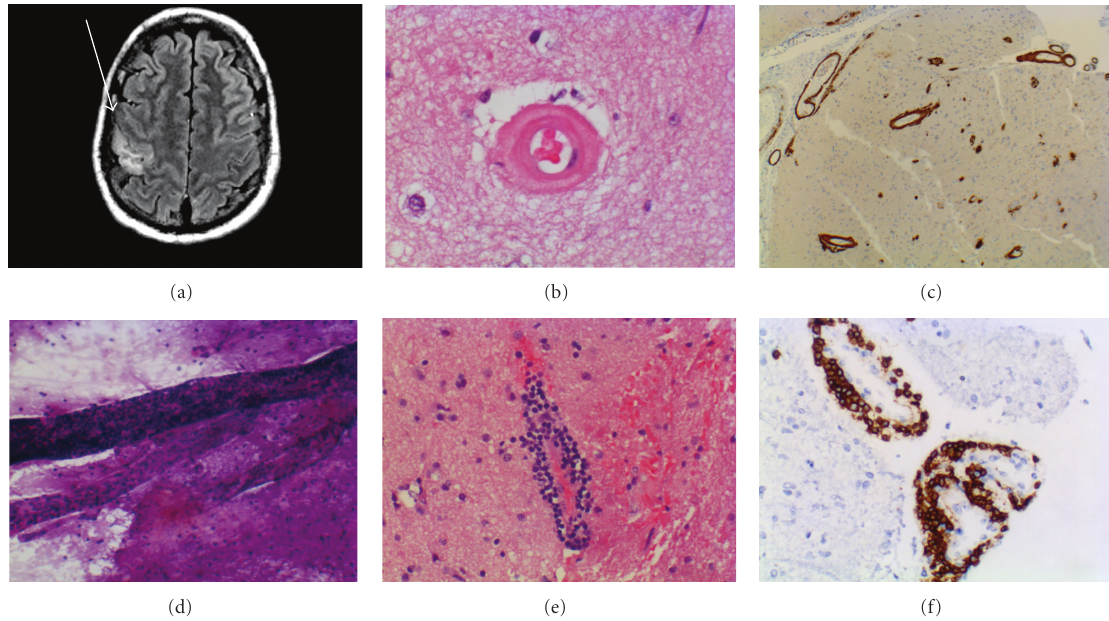
Figure 1: Amyloid-beta-related angiitis. (a) Magnetic resonance T2 FLAIR imaging at admission to Neuro ICU note hyperintense lesion in the grey and white matter in the right sensorimotor cortex. (b) Hematoxylin-eosin-stained section shows characteristic double barrel lumen appearance of an amyloid laden vessel. (c) Immunohistochemistry using monoclonal antibody against beta-amyloid reacting to vessels in the meninges and parenchyma. (d) Squash prep at time of surgery-blood vessel and extensive perivascular lymphocytic infiltrate. (e) Lymphocytic response with intramural vascular inflammation. (f) Antibody against CD3 demonstrates a perivascular T-cell